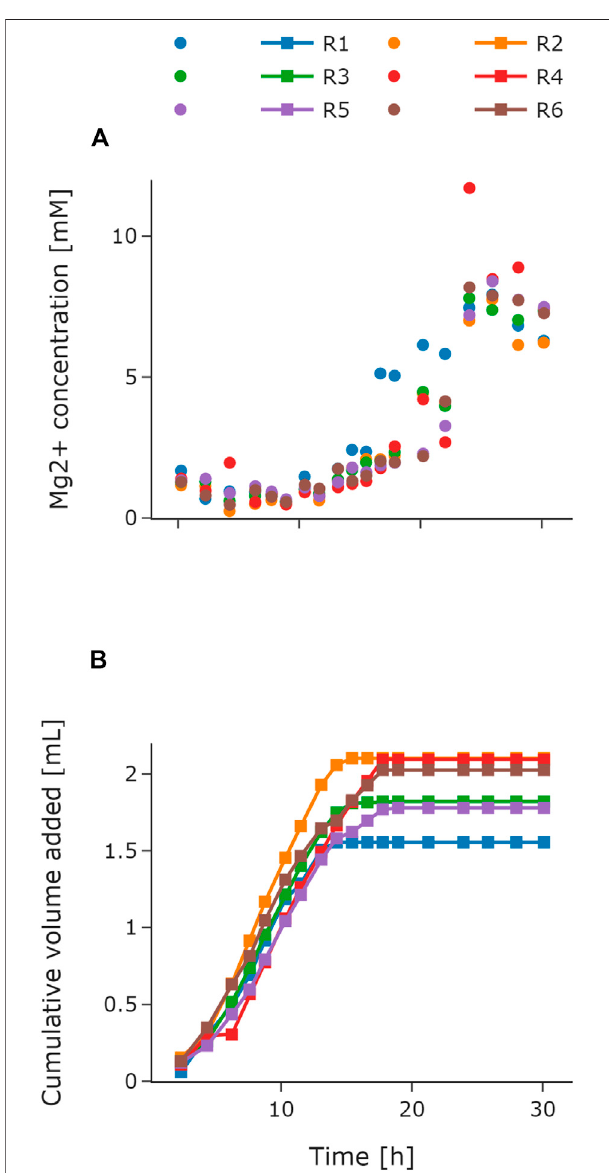
FIGURE 5 | Automated feedback operation for magnesium addition. Atline measured Mg 2+ concentrations throughout the cultivation for R1 – R6 (A) . Cumulative volume of the added magnesium solution for R1 – R6 (B) . The volume for each control cycle was calculated according to Section 3.3.1 with a set point of 2 mM. For R1 – R3, the exponential feed was set to μ set = 0.2 h − 1 for 6 h followed by a constant feed. For R4 – R6, the exponential feed was set to μ set = 0.15 h − 1 for 13 h followed by a constant feed. Mg 2+ , magnesium; R, reactor.